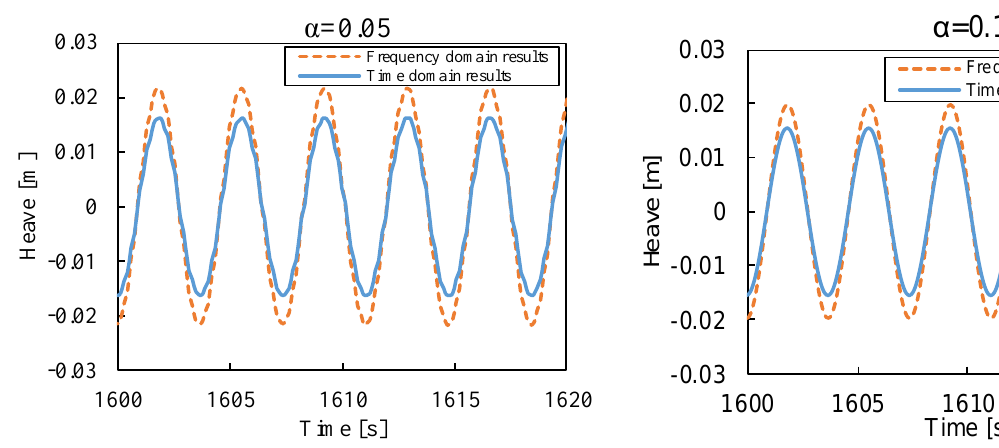
( a ) Comparison of the heave motions by the time and ( b ) Comparison of the heave motions by the time and